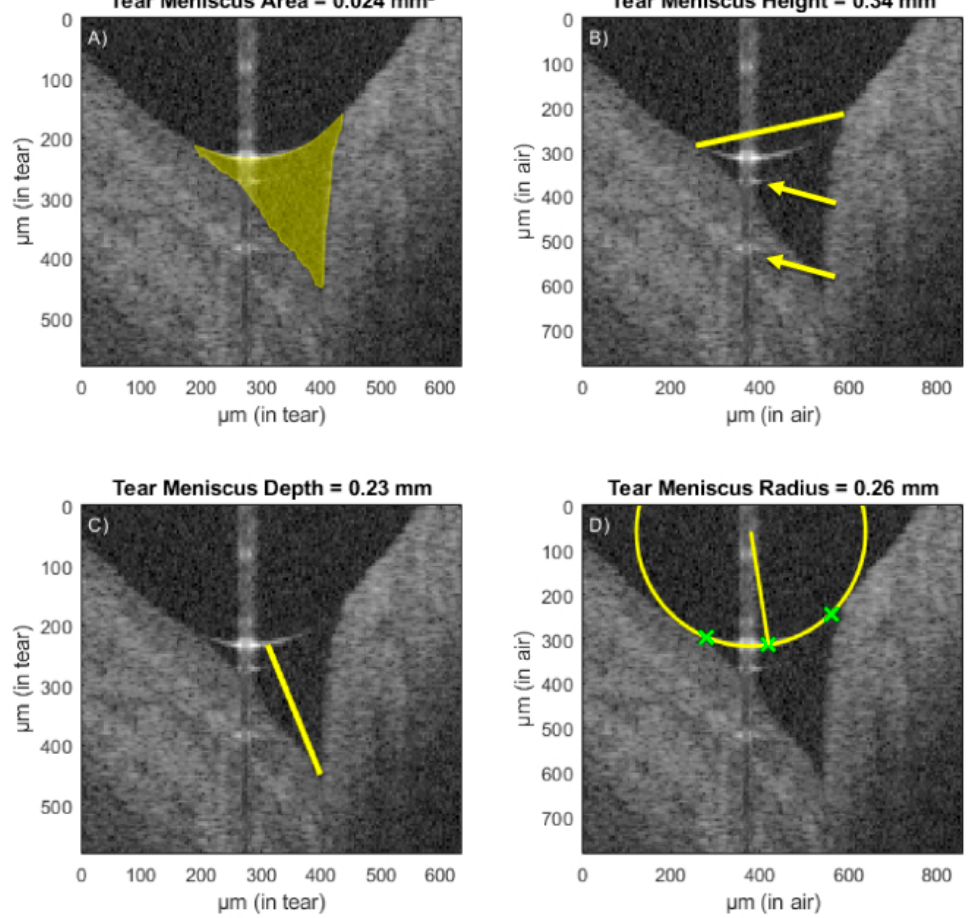
Figure 2. Assessment of tear meniscus area ( A ), tear meniscus height ( B ), tear meniscus depth ( C ) and tear meniscus radius ( D ) using ultrahigh-resolution optical coherence tomography. Reprinted from Stegmann et al. 2019 [36].